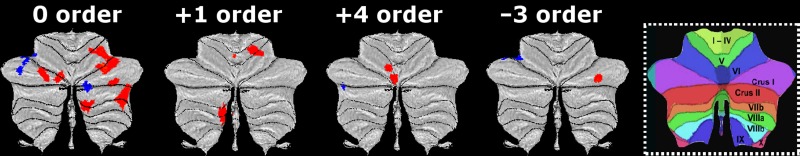
Cerebellar BOLD effects in action execution and observation. SUIT flat maps at the group level corresponding to different orders of the BOLD–GF association in action execution (AE) and action observation (AO) conditions. Note the force-related and main (0th order) BOLD effects in different cerebellar areas. In the images, areas of activation at different orders of effect are shown for both AE (in red) and AO (in blue). A SUIT flat map with labels of cerebellar lobules is shown in the bottom right corner. A threshold Pu < 0.001 (k ≥ 10; Pu= P uncorrected for multiple comparisons) was used for display purposes.